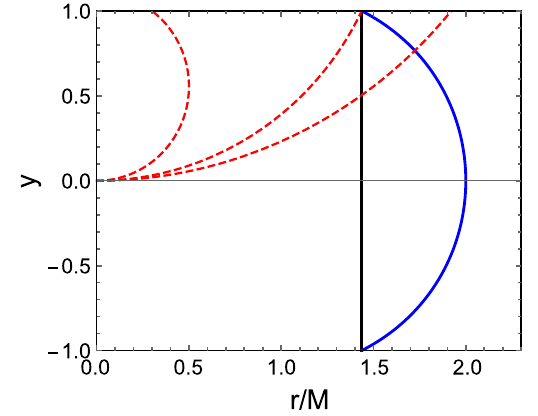
Fig. 1 Different hypersurfaces in the Kerr-like spacetime are depicted on the ( r , y ) plane. We assume a / M = 0 . 9. The outer event horizon and the ergosurface are uniquely determined by a / M and they are shown by the vertical black line and the blue curve, respectively. The dashed red curves represent the curvature singularity. We consider the deviation function ˜ (cid:2)( y ) = (cid:2) May . The red curves from left to right correspond to (cid:2) = − 1, (cid:2) = − (cid:2) ≈ − 3 . 2, and (cid:2) = − 5, respectively. The intersection sin betweenthedashedredcurveandtheblacklineindicatestheappearance of naked